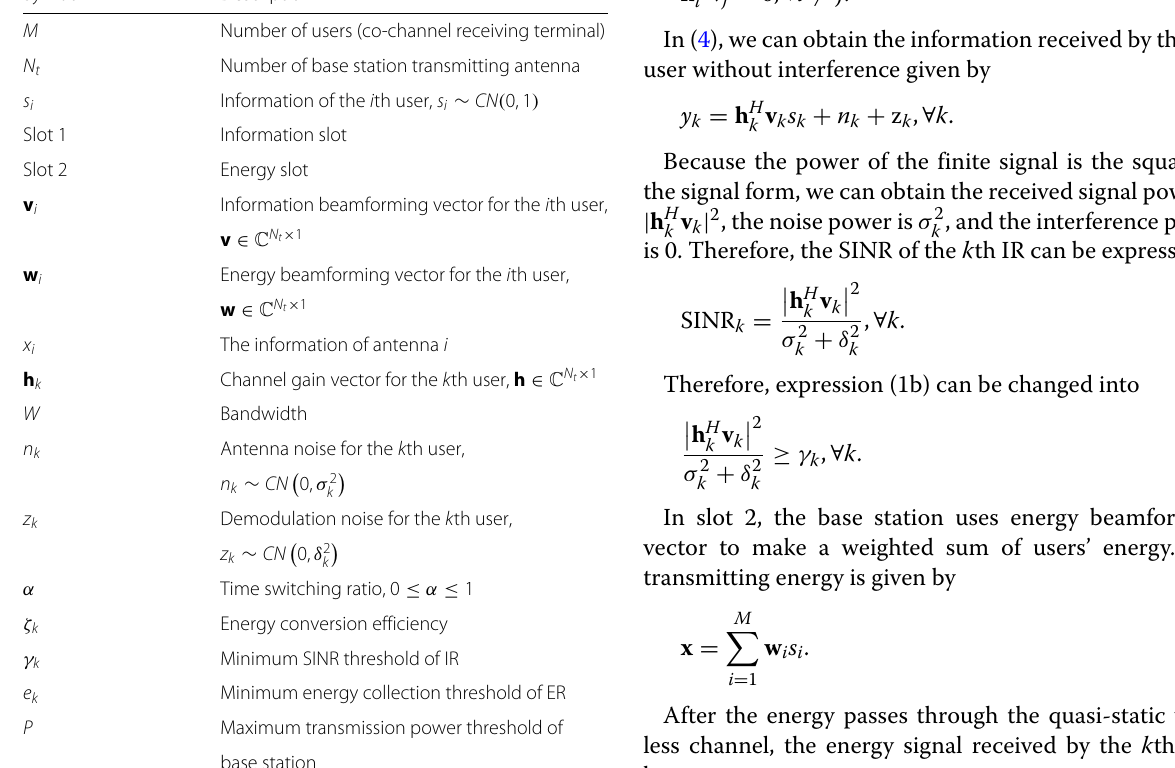
Table 1 List of major symbols used in this papers